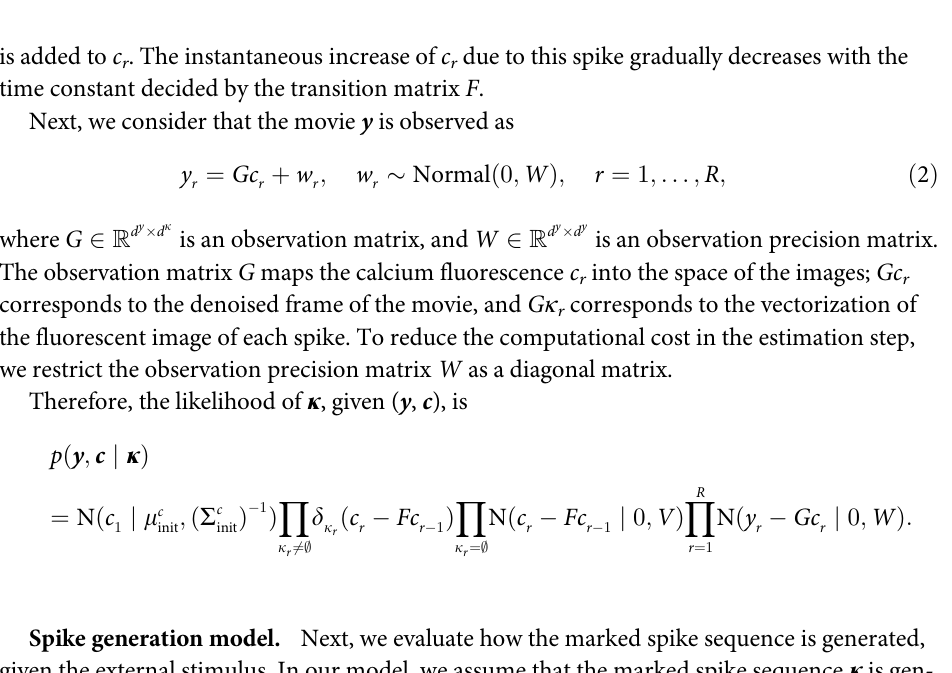
Fig 9. Calcium fluorescence model. The marked spike sequences κ contain fluorescent footprints of the spikes. Given κ , the calcium fluorescence c and the observed movie y are generated from a linear state space model including jumps. Because c and κ are not defined on the space of y , these variables are represented as transformed versions Gc r r r this figure for intuition. When a spike occurs, the footprint of this spike is added to the calcium fluorescence, and then, it gradually decreases according to the calcium ion decay dynamics. The blue and green components indicate that the fluorescent footprints of the spikes originated from different neurons.